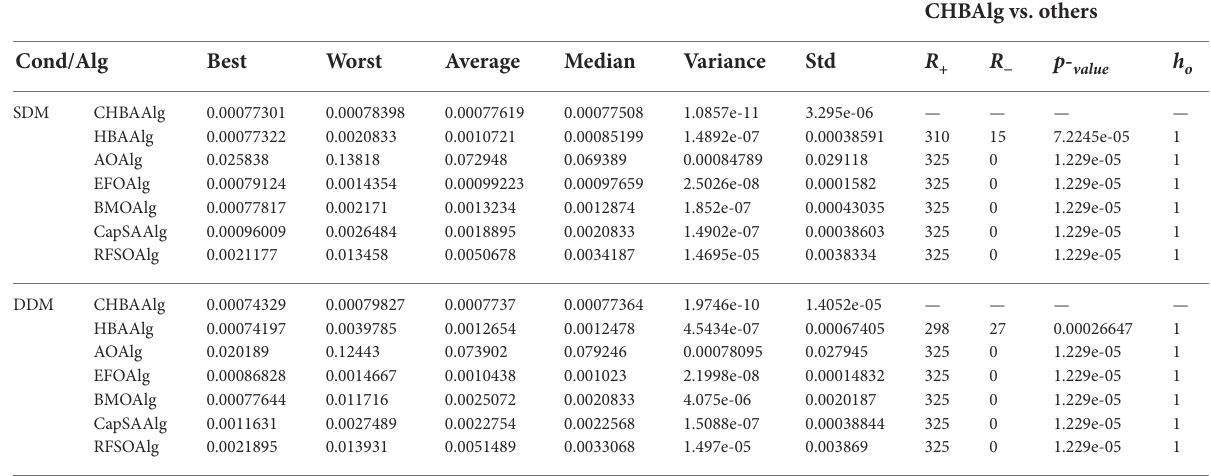
TABLE 2 TheobtainedresultsbyCHBAAlg,andothertechniquesinthecaseofSDMandDDMoftheRTCcell. Statically metrics WSRT